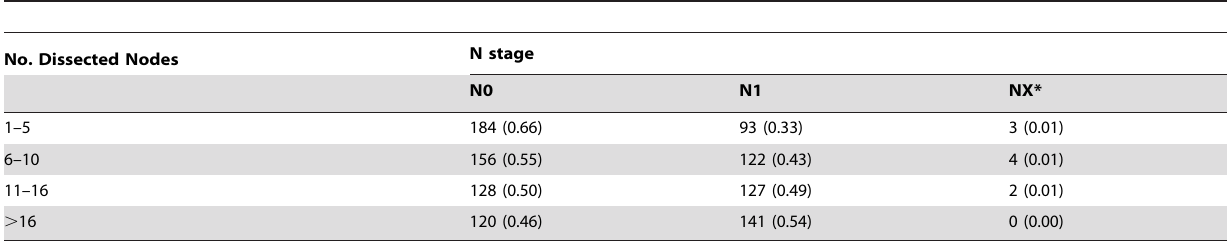
Table 3. The Number and Percentage of N Stage for Different Total Nodal Count Intervals for Invasive IPMN Patients: Surveillance, Epidemiology, and End Results 1992 to 2011.